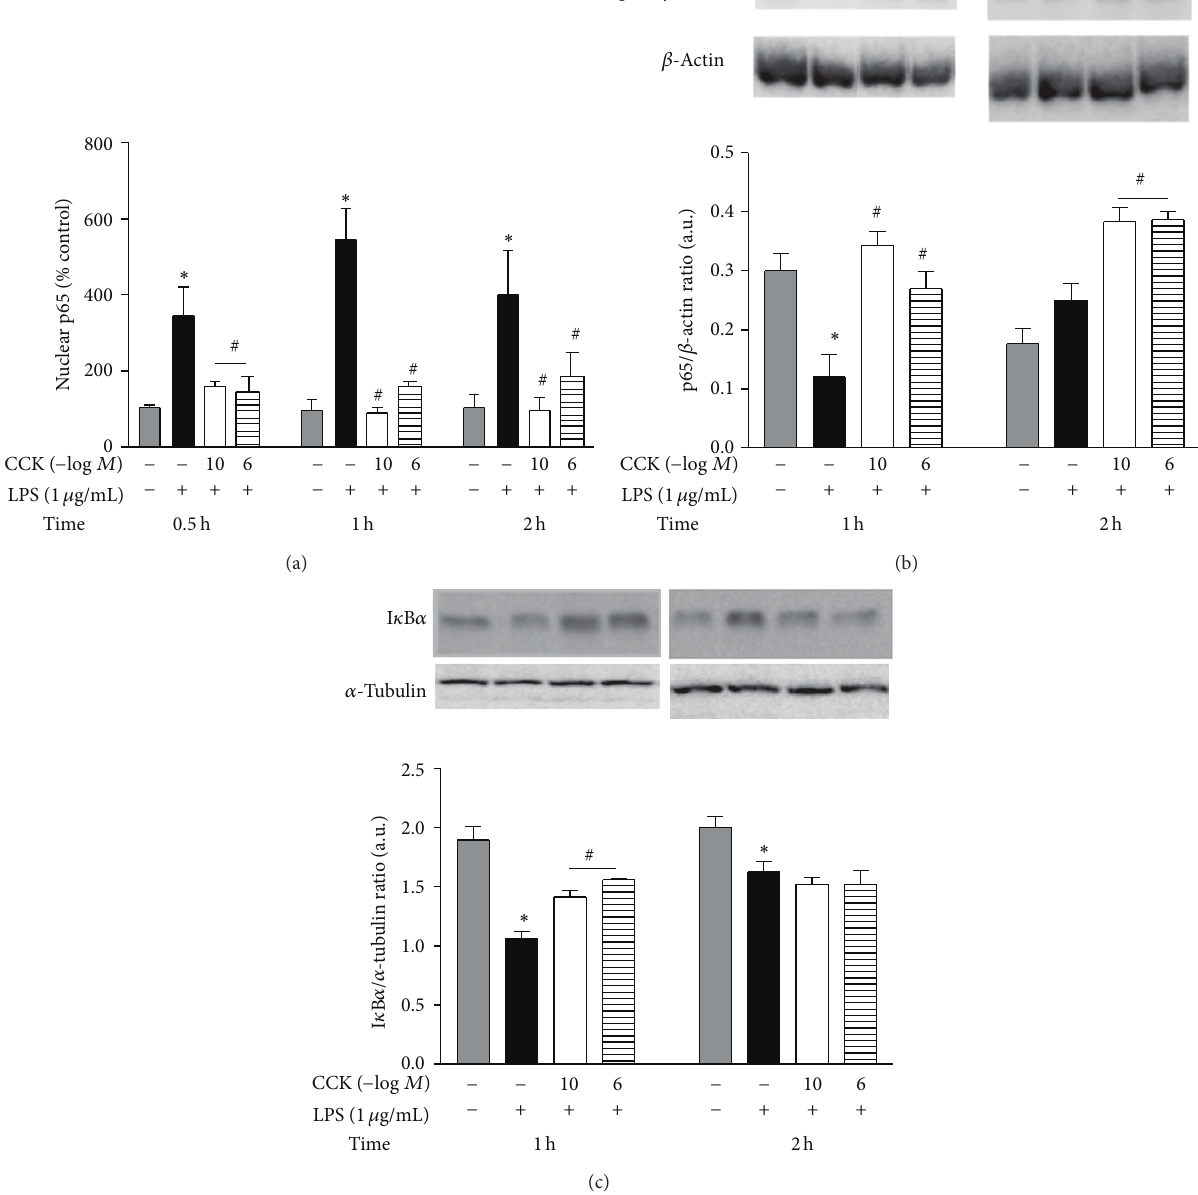
Figure 2: CCK reduces LPS-induced NF- 𝜅 B activation and p65 translocation to nucleus and also delays I 𝜅 B 𝛼 degradation by peritoneal macrophages. The macrophage culture was pretreated with CCK (10 −10 or 10 −6 M) for 30 min before the addition of LPS (1 𝜇 g/mL) to the cell culture medium (time zero). At the indicated time-points, nuclear proteins were extracted for the quantification of p65 translocation by using ELISA kit (a). The nuclear p65 concentration was presented as the percentage relative to the control (saline) group. Cytosolic proteins were also extracted for the determination of p65 content and I 𝜅 B 𝛼 degradation by western blot. Representative immunoblots with densitometry values were showed for p65/ 𝛽 -actin ratio (b) and I 𝜅 B 𝛼 / 𝛼 -tubulin ratio (c). The 𝛽 -actin and 𝛼 -tubulin levels were used as internal controls. Data is a representative of three independent experiments with similar results. Values are expressed as means ± S.E.M. 𝑛 = 4–10 samples per group. ∗ 𝑃 < 0.05 versus saline and # 𝑃 < 0.05 versus LPS